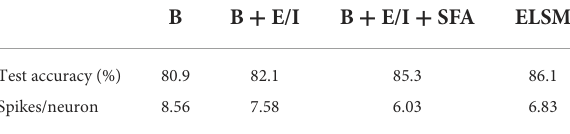
TABLE 3 Effect of different SFA setups on the test accuracy and the TABLE 4 The individual impact of all proposed extensions to the number of spikes per neuron. baseline LSM (B) 2000-neuron B B + E/I SFA, SFA, SFA small τ sfa large τ sfa (range) Test accuracy (%) 80.9